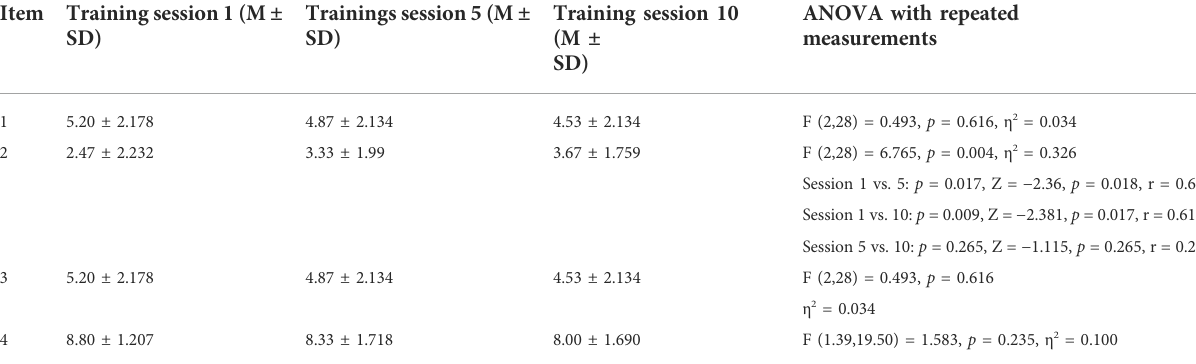
TABLE 4 Results for subjective assessment of VR training ’ by VRG (n = 15) after 1st, 5th, , and 10th training session. Item 1: I enjoy training in virtual reality. Item 2: Training against a virtual opponent ismore exhausting than against a real opponent. Item3: Icanreact tothe attacks of the avatar in the same way as to attacks of a real athlete. Item 4: I feel comfortable in VR. (1 — strongly disagree, 10 — strongly